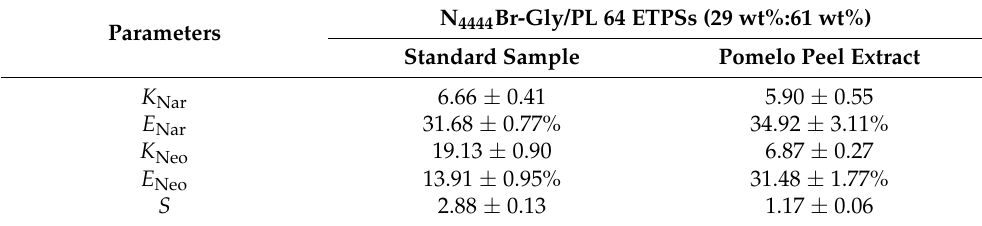
Table 2. K , E , and S values in N 4444 Br-Gly/PL 64 ETPSs for the extraction of Nar and Neo from the standard and pomelo peel extract samples. The extract was prepared by adding 10 mL ethanol to 400 mg peel powders assisted by an ultrasonic cell pulverizer at 40 °C for 30 min.